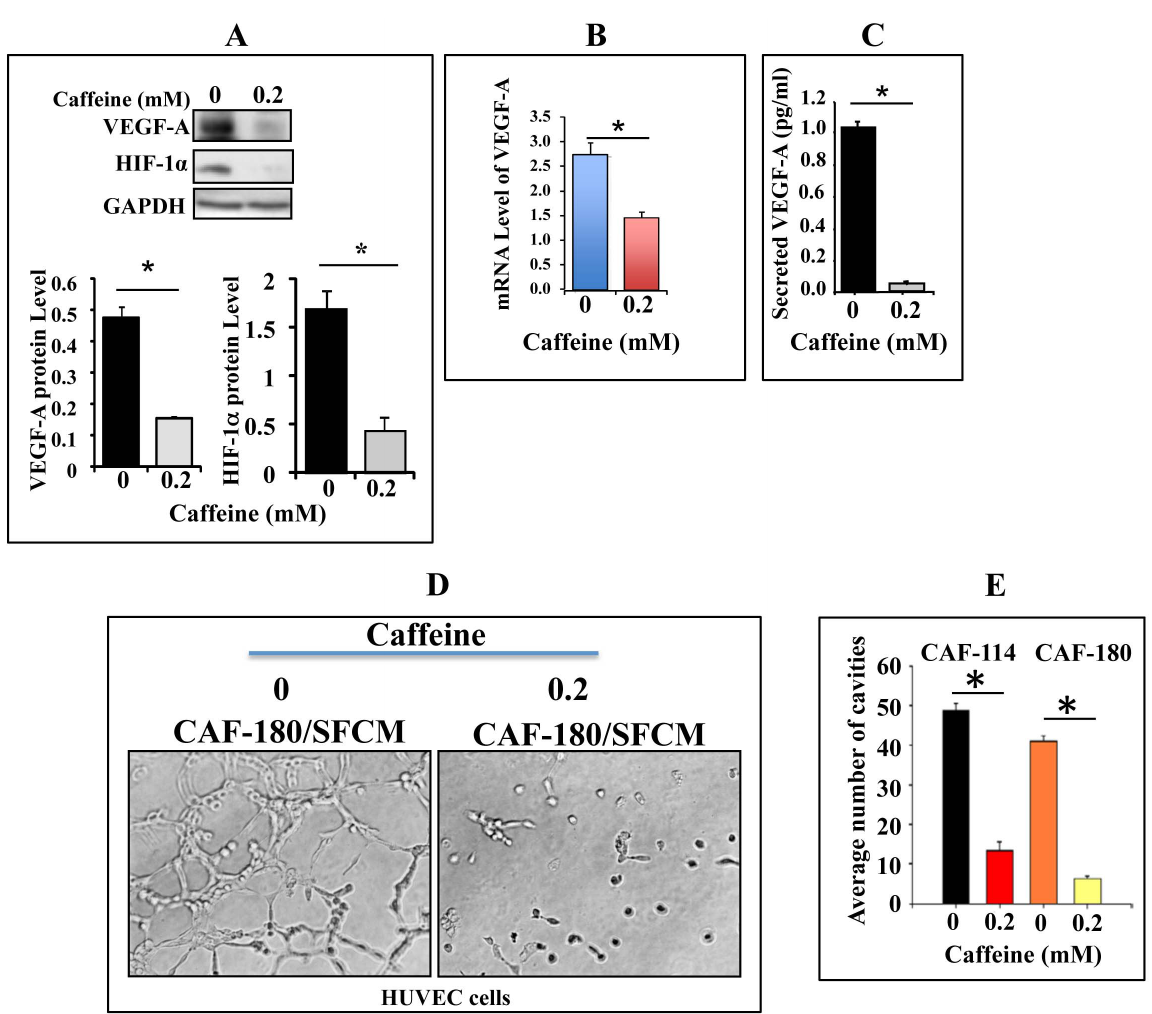
Figure 6. Caffeine inhibits VEGF-A expression/secretion in stromal fibroblasts and their pro-angiogenic effects invitro . CAF-180 cells were either sham treated or challenged with caffeine for 1 hr. (A) Whole-cell lysates were prepared and 50 m g of proteins were used for immunoblotting analysis using the indicated antibodies (upper panel). The histograms show the expression levels of the indicated proteins (lower panels). (B) Total RNA was prepared and used to assess the level of VEGF-A by qRT-PCR. The obtained values were normalized against b -actin. (C) CAF- 180 cells were treated with caffeine for 1 hr. Non-treated cells were cultured under the same conditions and were used as control. Secreted levels of proteins were determined by ELISA and shown in the histogram. (D ) Cells were either sham-treated or challenged with caffeine (0.2 mM) for 1 hr, and then caffeine was removed and cells were washed twice with PBS and were subsequently reincubated in SFM for 24 hr to generate SFCM that have been used to treat HUVEC cells previously plated on matrigel (96-well plate), then incubated at 37 u C for 18 hr. (E) Histogram shows the average number of formed cavities. Error bars represent means 6 S.D. *: p , 0.05.